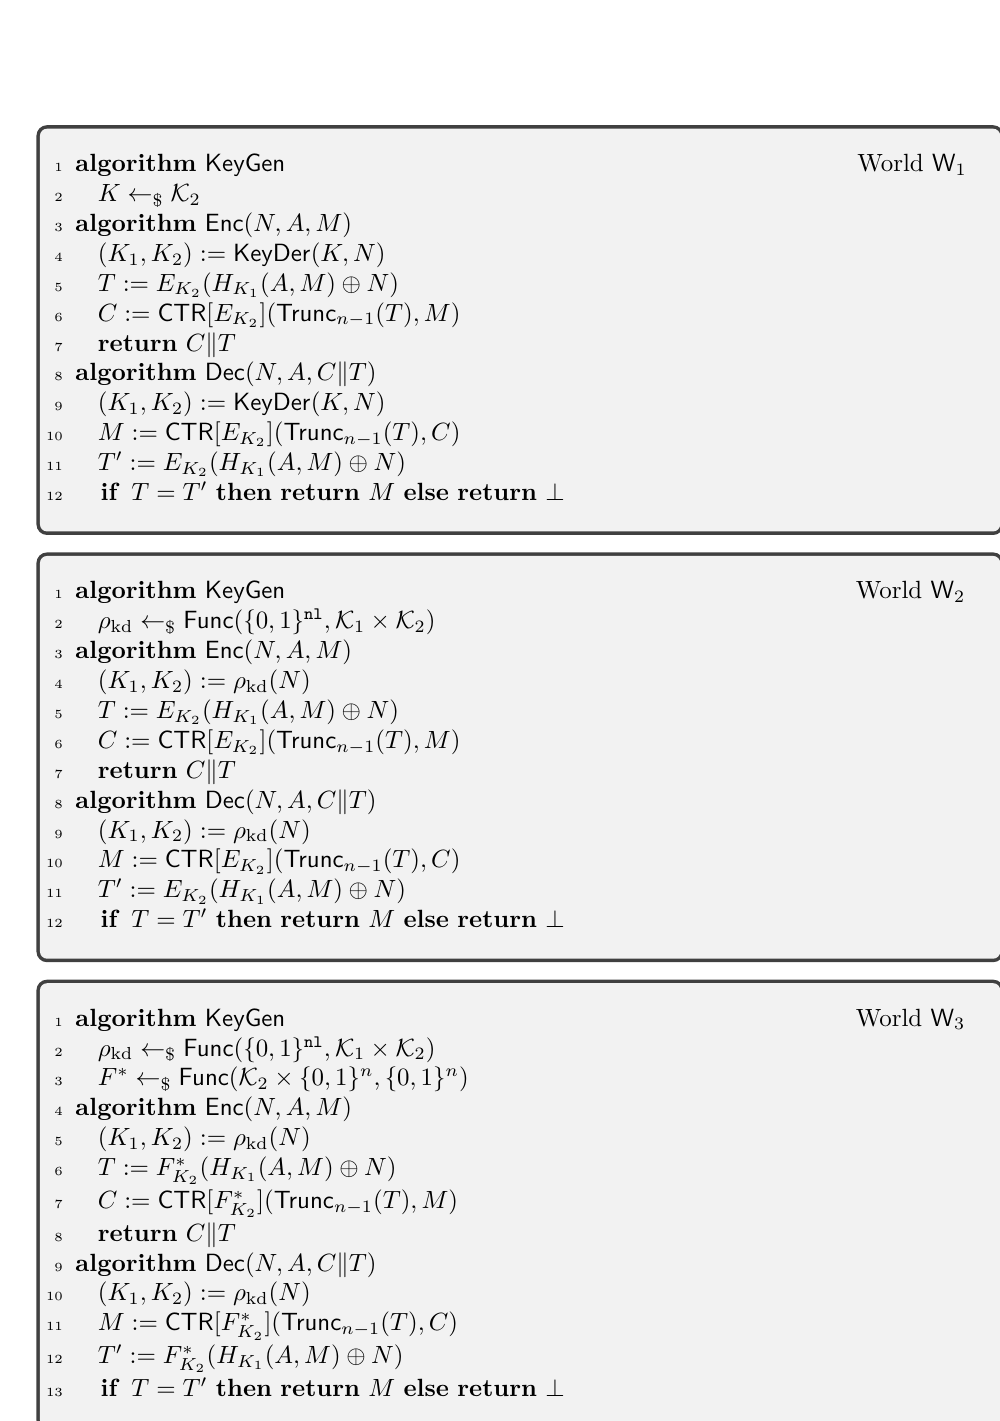
Figure 2: Worlds W 1 - W 3 used in the proof of Theorem 3. The keyed hash function H is defined as in Equation